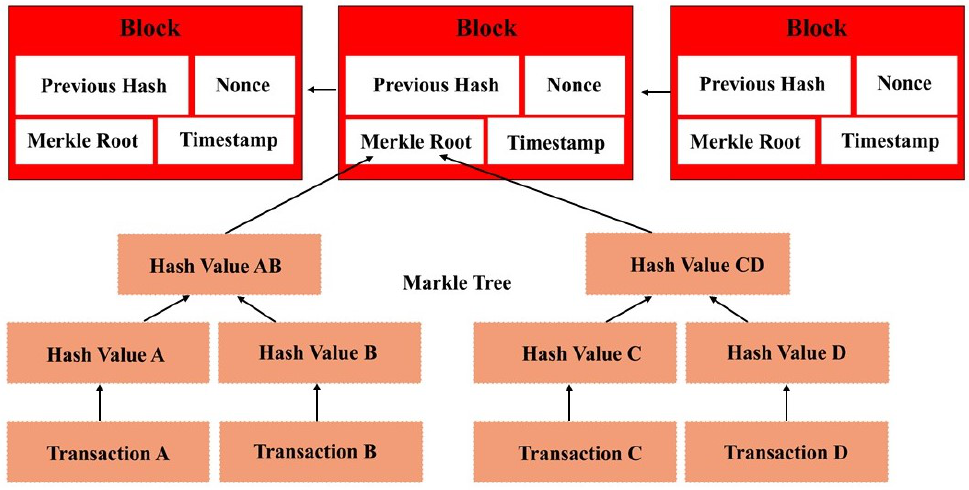
Figure 6. Block header and its